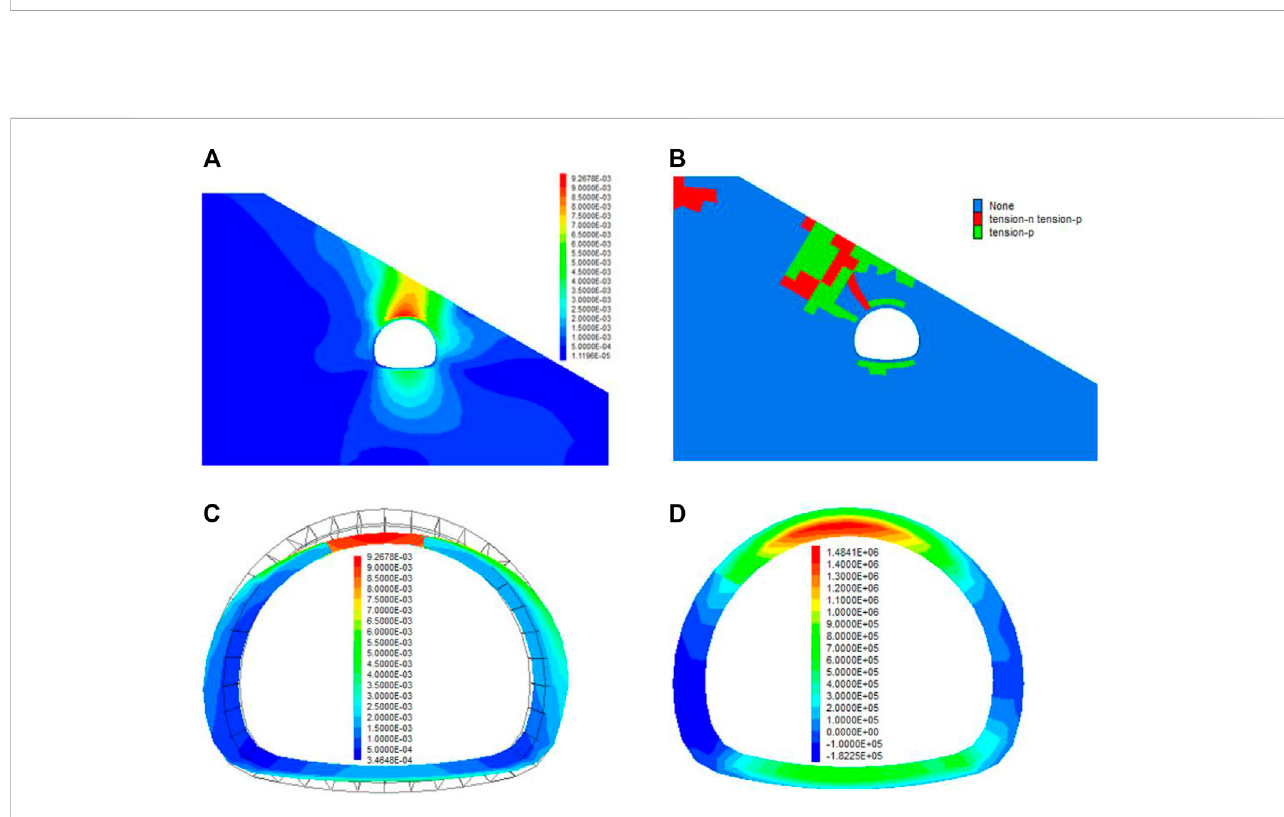
FIGURE 22 Controlling effects of grouting steel pipes: (A) Deformation of surrounding rock (unit: m); (B) Plastic zone of surrounding rock; (C) Deformation of secondary lining (unit: m); and (D) First principal stress of secondary lining (unit: